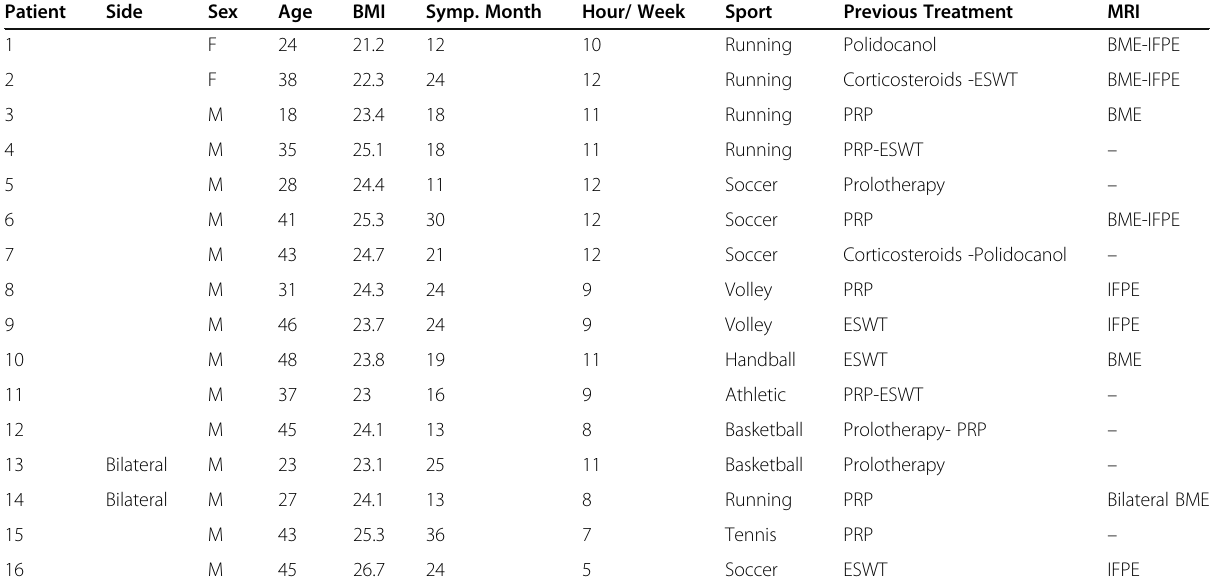
Table 1 Sample description